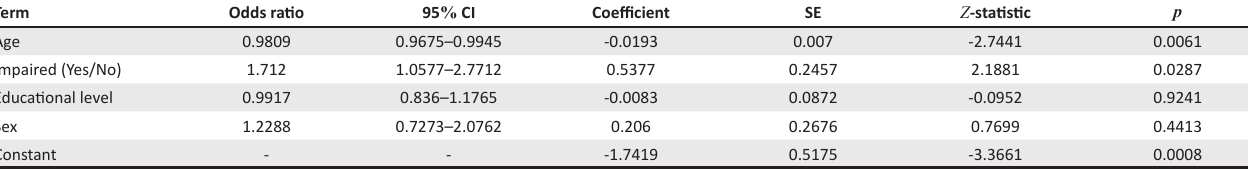
TABLE 5: Logistic regression analysis showing relationship between some independent characteristics and occurrence of road traffic accident. Term Odds ratio 95 % CI Coefficient